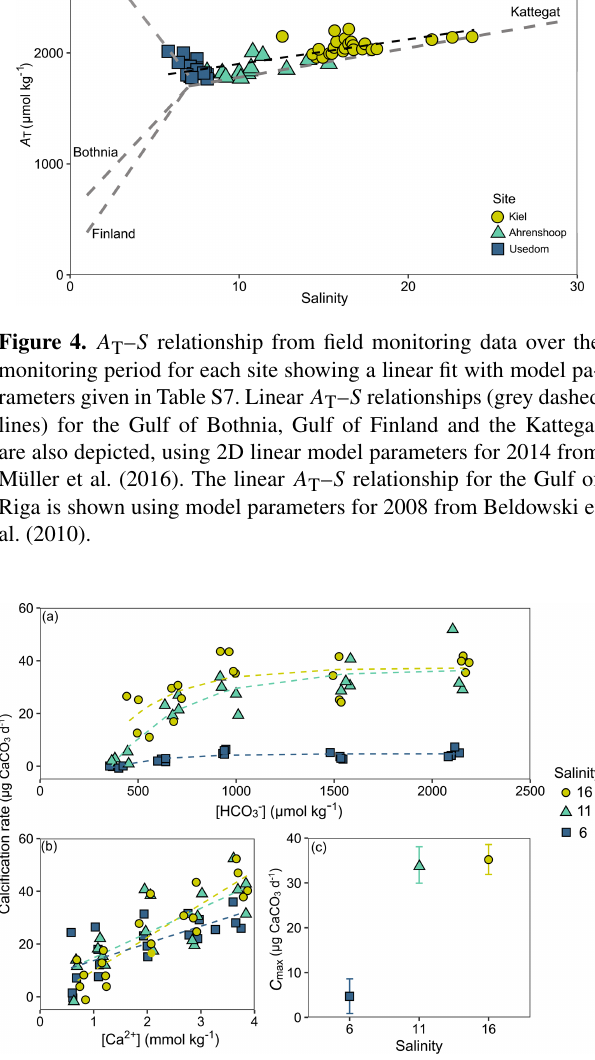
Figure 5. Individual calcification rates (µgCaCO 3 d − 1 ) in both lab- oratory experiments. Calcification rates across [HCO − bonate experiment are shown with negative exponential decay mod- els for each salinity treatment (a) . Calcification rates across [Ca 2 + ] in the calcium experiment are fitted with linear trend lines for each salinity treatment (b) . The model parameter C max (µgCaCO 3 d − 1 ) for each salinity in the bicarbonate experiment is depicted ± 95% confidence interval (c)